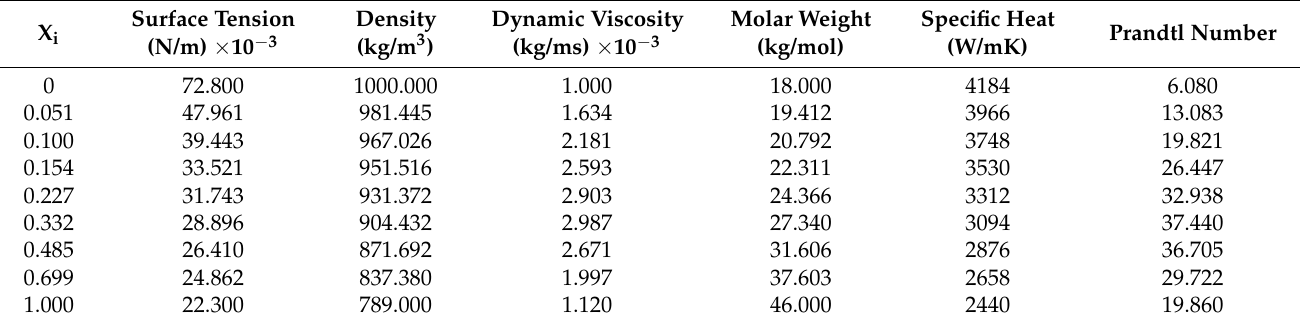
Table 2. Physical properties of the water + ethanol mixture with corresponding ethanol molar fraction values at the temperature of 293 K. The datasets are taken from [24,25]. Surface Tension X i